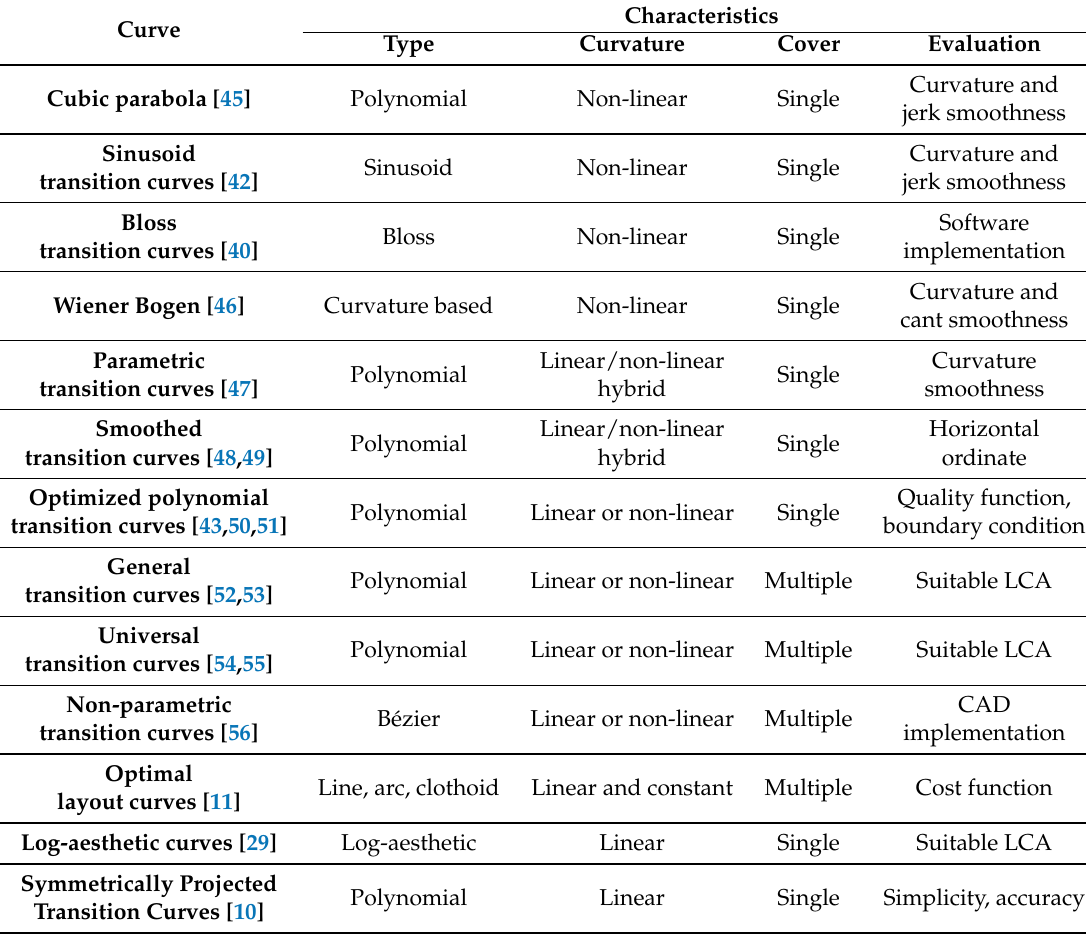
Table 1. A summary of the characteristics connected to the presented transition